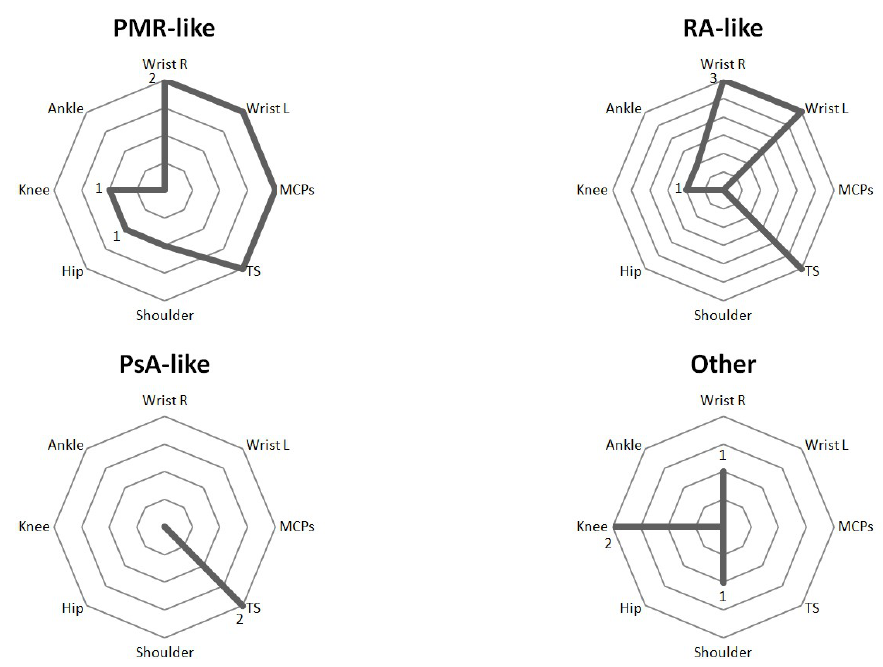
Figure 4. Spider diagram of US findings according to ICI-induced arthritis patterns. MCP: metacarpophalangeal joint. PMR-Like: Polymyalgia rheumatica like, PsA-like: psoriatic arthritis like, RA-like: rheumatoid arthritis like, TS: tenosynovitis.